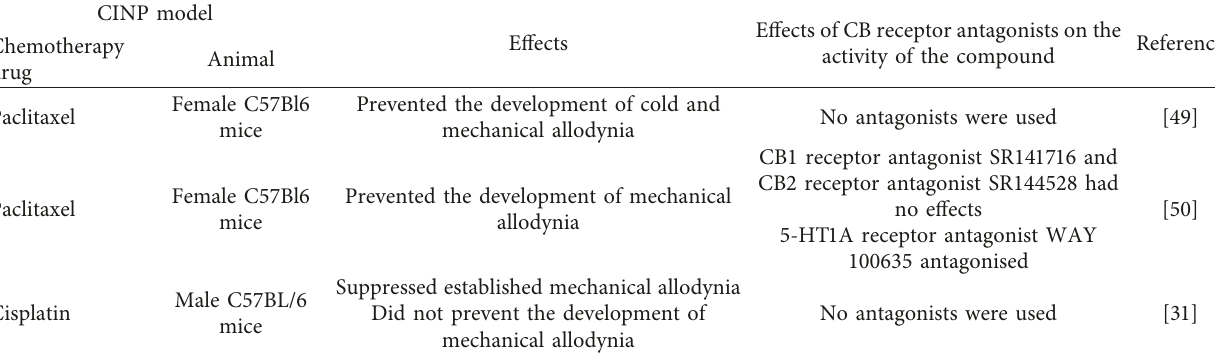
Table 4: Effects of cannabidiol in animal models of